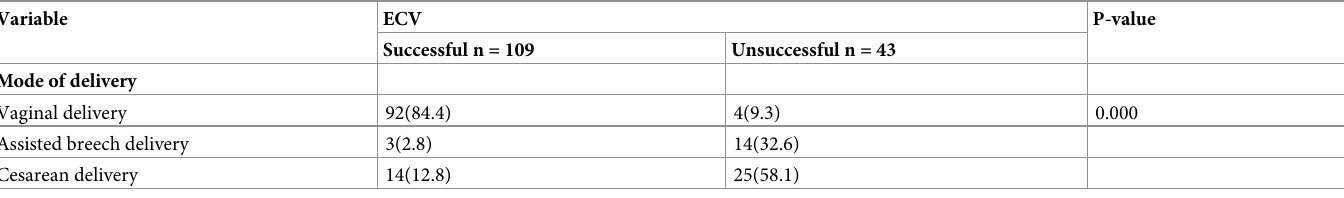
Table 2. Distribution of mode of delivery and fetal presentation at